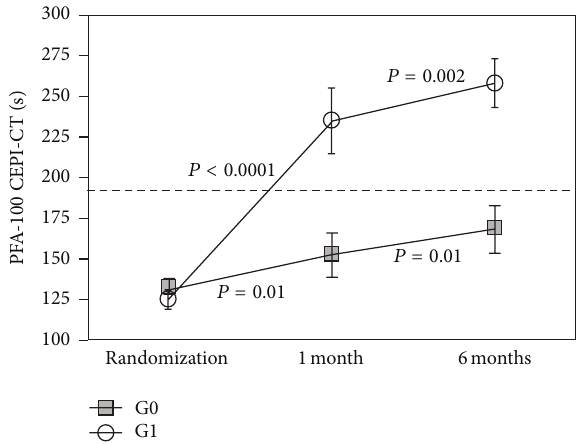
Figure 2: Ischemic and bleeding events during 6-month follow-up in G0 and